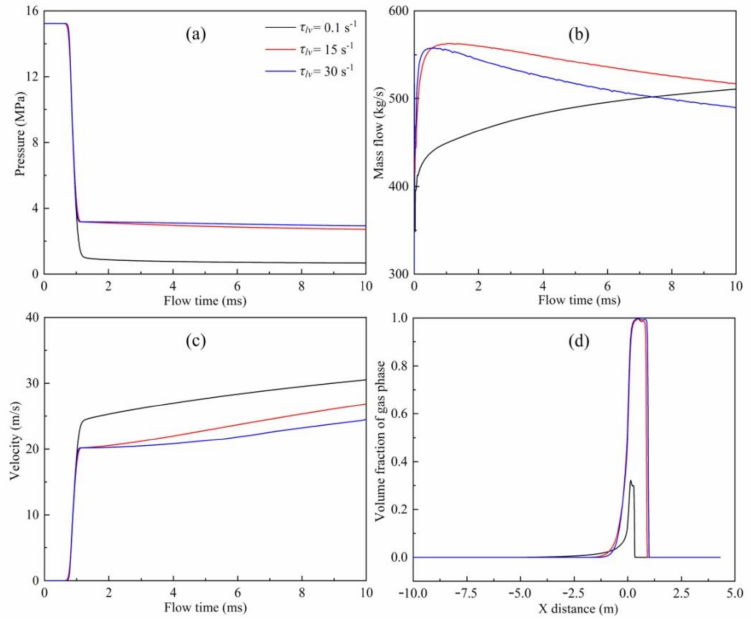
Figure 3. Effects of evaporation coefficient τ lv on ( a ) pressure, ( b ) mass flow, ( c ) flow velocity and ( d ) volume fraction of gas CO 2 phase at flow time of 10 ms. The location of 0.0 m is the rupture opening.